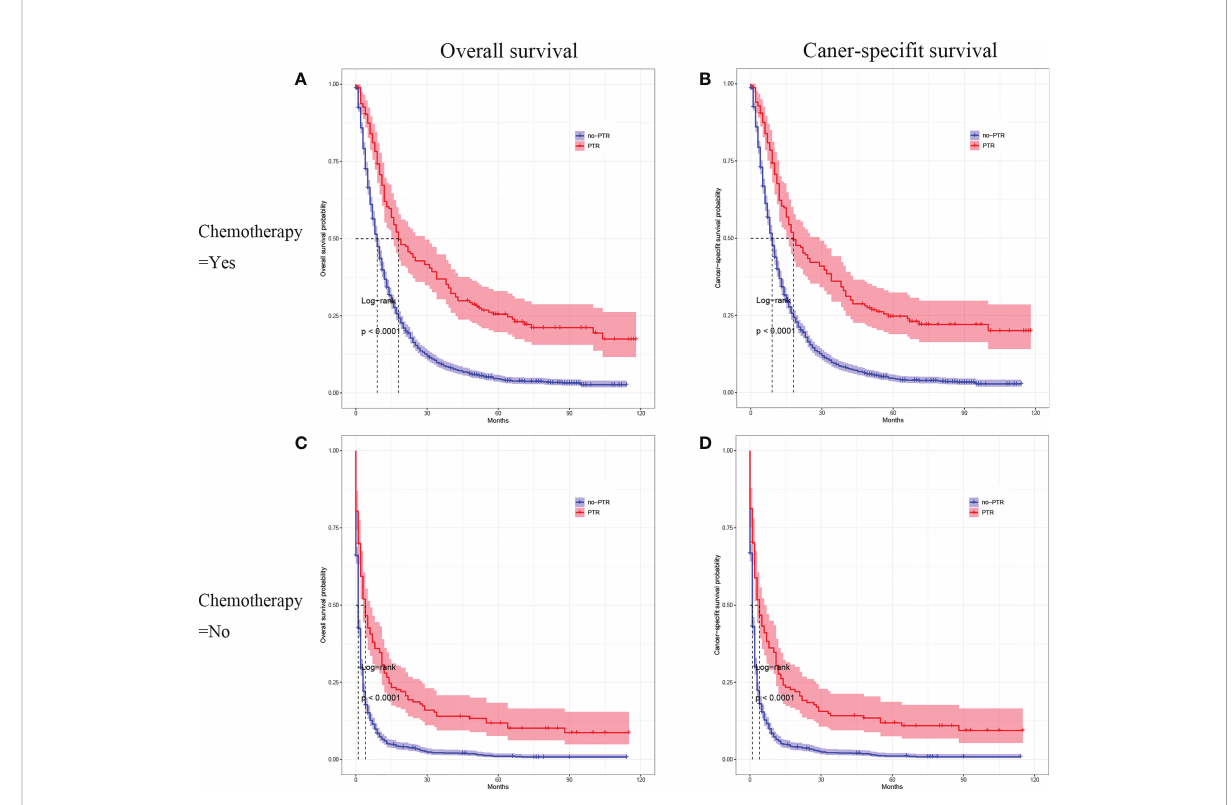
FIGURE 5 Kaplan – Meier curves for overall survival and carcinoma-speci fi c survival of patients with primary tumor resection versus without primary tumor resection strati fi ed by chemotherapy in the unmatched